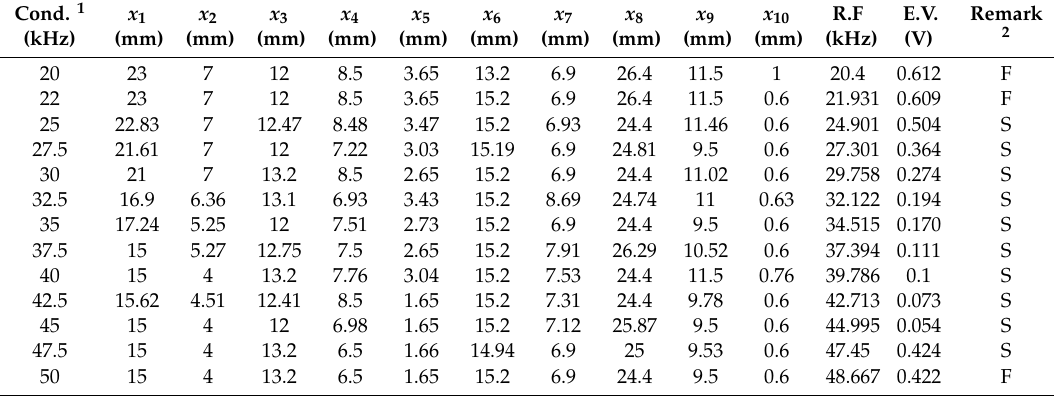
Table 4. Values of optimized design variables at different target resonant frequencies and corresponding resonant frequency and electric voltage.